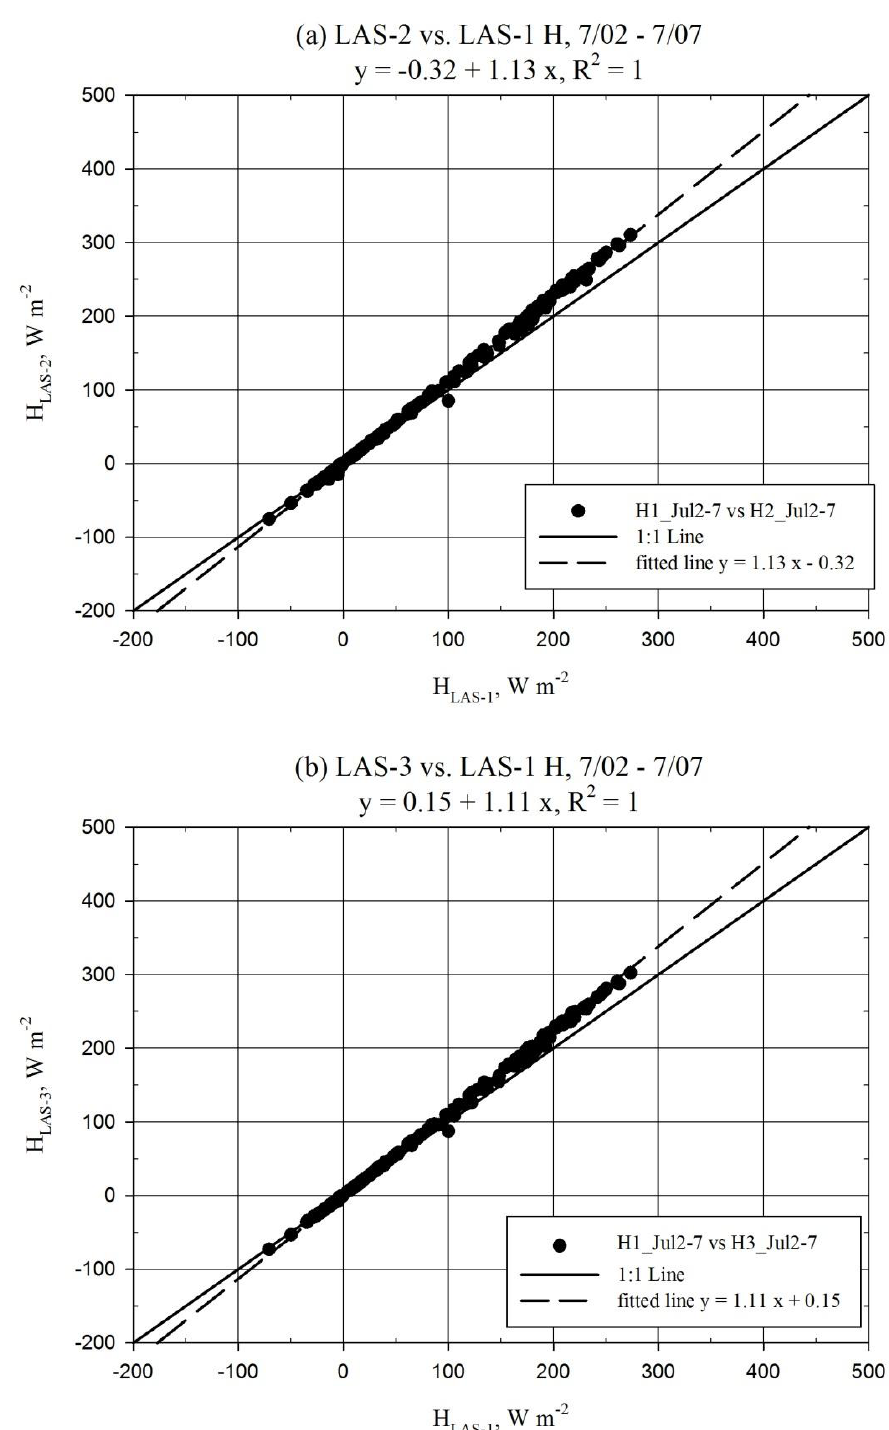
Figure 4. Regression plots for sensible heat flux ( H , W·m −2 ) of LAS-1, LAS-2, and LAS-3, for 2–7 July ( a , b ), 8–21 July ( c , d ), and 22 July–3 August ( e , f ); LAS-1 is reference. Results filtered for precipitation only. Dashed line represents best-fit linear regression; solid line represents the 1:1 relationship. Regression slopes were statistically significantly different from 1.0 in each case (Table